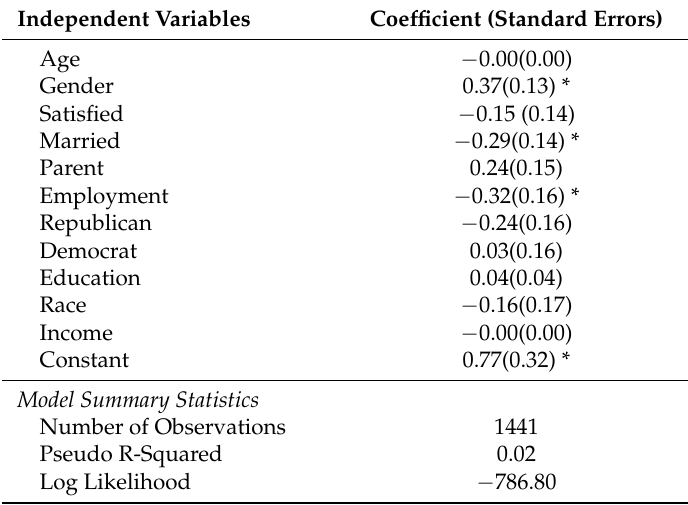
Table 2. Logistic Regression evaluating which individuals are most likely to post online comments in 2010 (Pew Internet & American Life Project